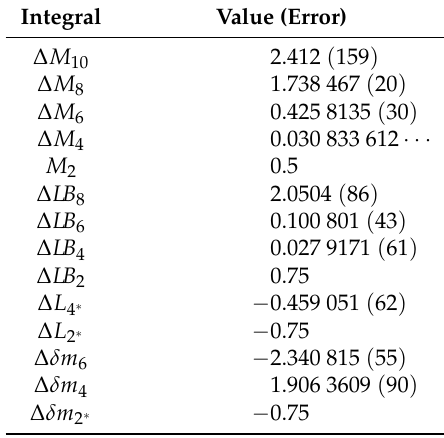
Table 3. Residual renormalization constants used to calculate A ∆ dm 2 n are the sum of the finite magnetic moment amplitudes, the sum of the finite parts of vertex and wave-function renormalization constants, and the sum of the finite parts of the mass-renormalization constants, respectively, all derived from the 2 n th-order diagrams without a fermion loop of the QED perturbation theory. They are given in units of ( α / π ) 2 n . ∆ M 10 is newly calculated for this paper. ∆ M 8 is derived from the near-exact result Equation (5) of